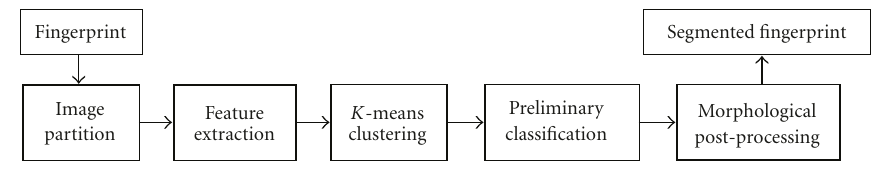
Figure 6: Framework of SKI.